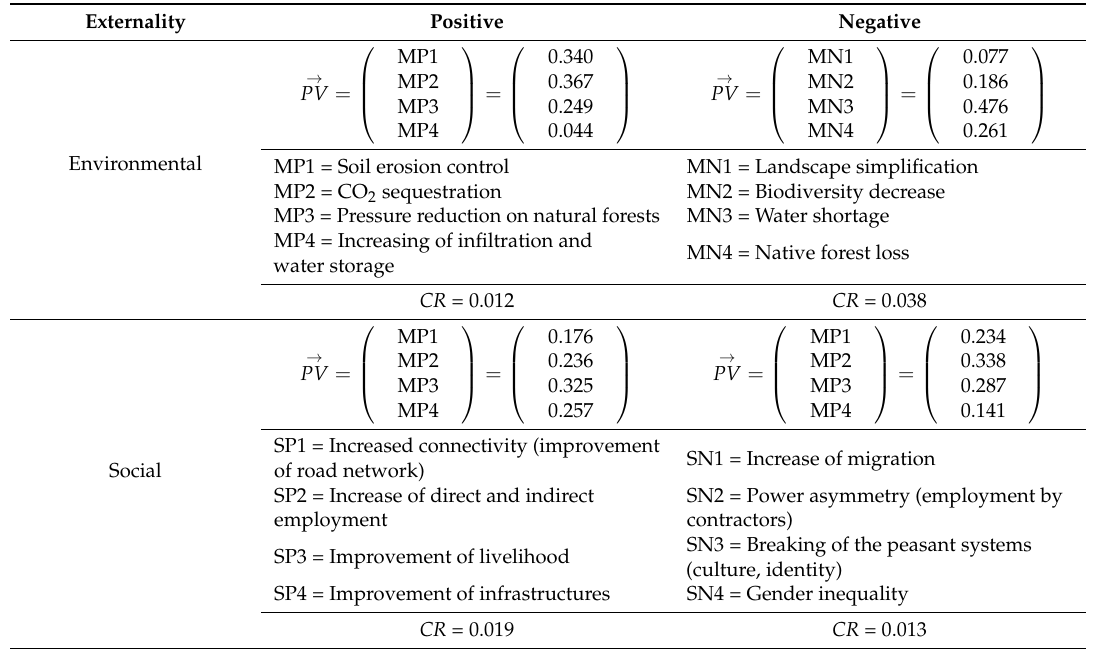
Table 4. Priority Vectors and Consistency Ratios for the study